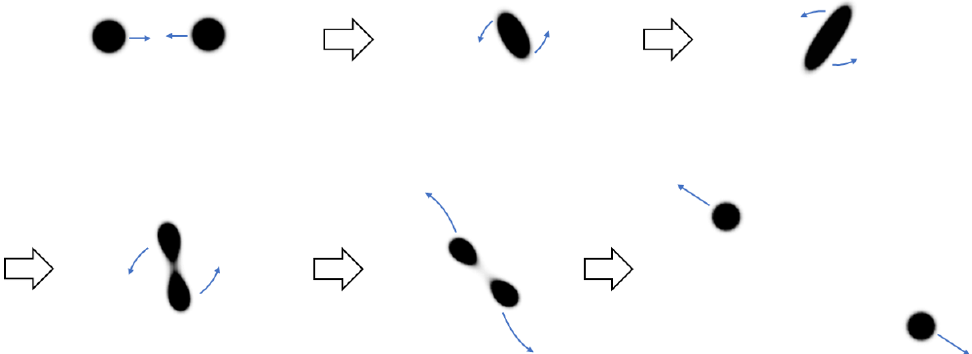
Figure 1 . Two spinning black holes collide and form a rotating black bar, which then breaks up into two outgoing black holes di(cid:11)erent than the initial ones (the (cid:12)gures are high-contrast density plots of the mass density obtained from the numerical simulation of a collision in the large- D e(cid:11)ective